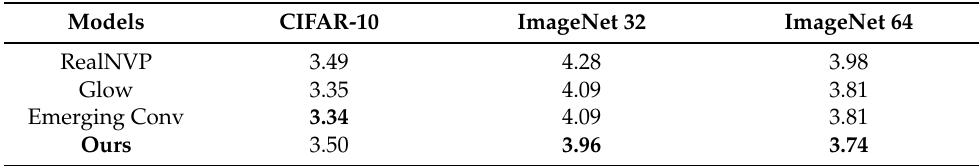
Table 2. Comparative results (bits per dimension) of proposed invertible n × n convolution compared to RealNVP, Glow and Emerging Convolution.